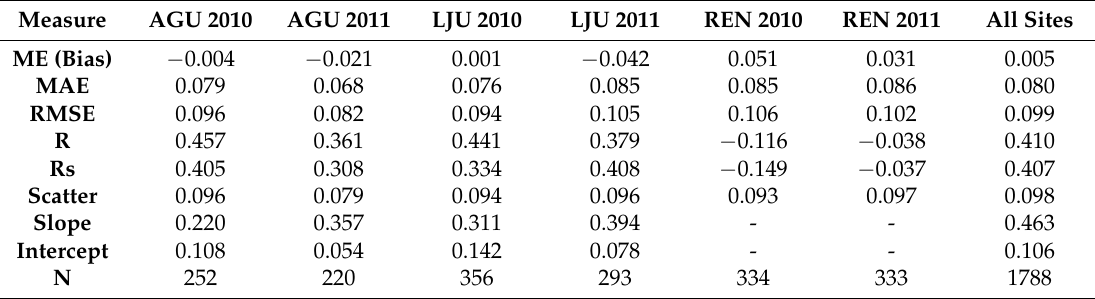
Table 2. Comparison between satellite (ASCAT 25Km) and observed Surface Soil Moisture (SSM) at the validation sites in EUROPE based on land cover type for 2010 and 2011. Slope and Intercept for REN are omitted due to lack of definite